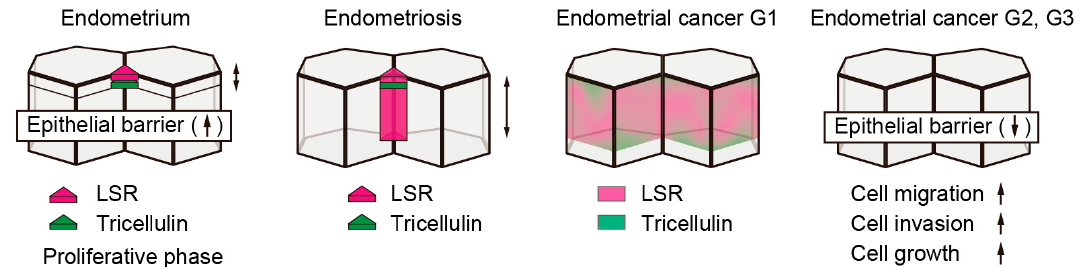
Figure 2. Expression and localization of LSR and tricellulin during endometriosis and in endometrial cancers. LSR and tricellulin localized in tricellular contacts in endometrium. During endometriosis, tricellulin is localized in the subapical region of tricellular contacts and LSR is localized in not only the subapical tricellular contacts but also in the lateral tricellular contacts. In endometrial cancer G1, tricellulin and LSR were distributed unevenly from the subapical to the lateral region of bicellular junctions. In endometrial cancer G2 and G3, the expression levels of tricellulin and LSR were downregulated, resulting in decrease of epithelial barrier and increase of cell migration, cell invasion, and cell growth.